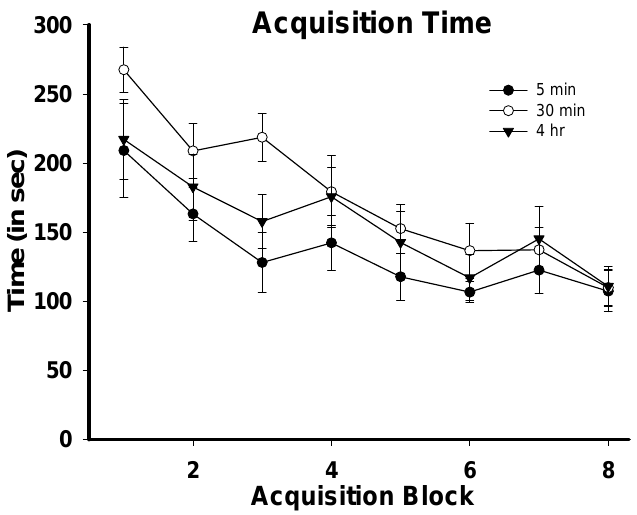
Figure 1. Mean latencies to complete the training phase of the SWSh RAM task during acquisition. Each data point represents the group mean (±SEM) of each experimental group for training block 1–8.